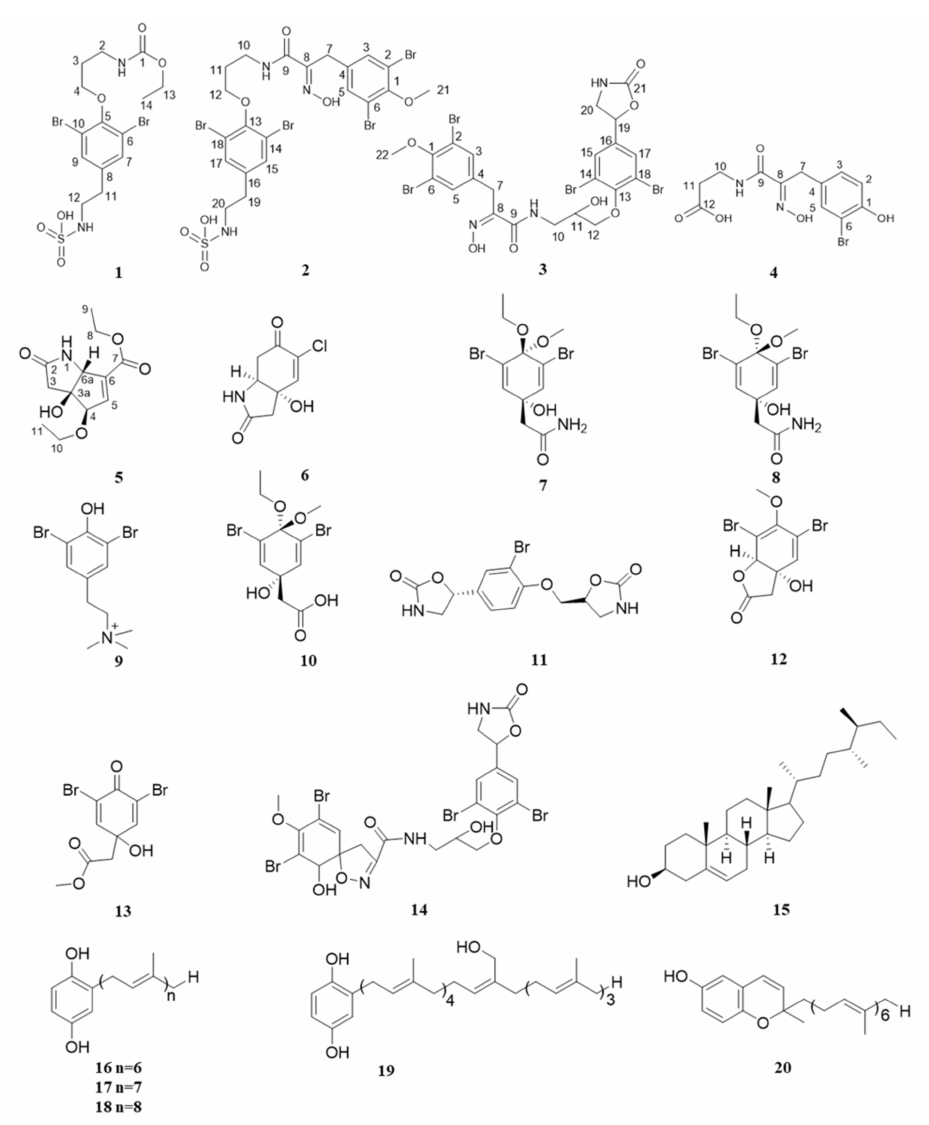
Figure 1. The chemical structures of compounds 1 to 20 as elucidated by NMR and MS;